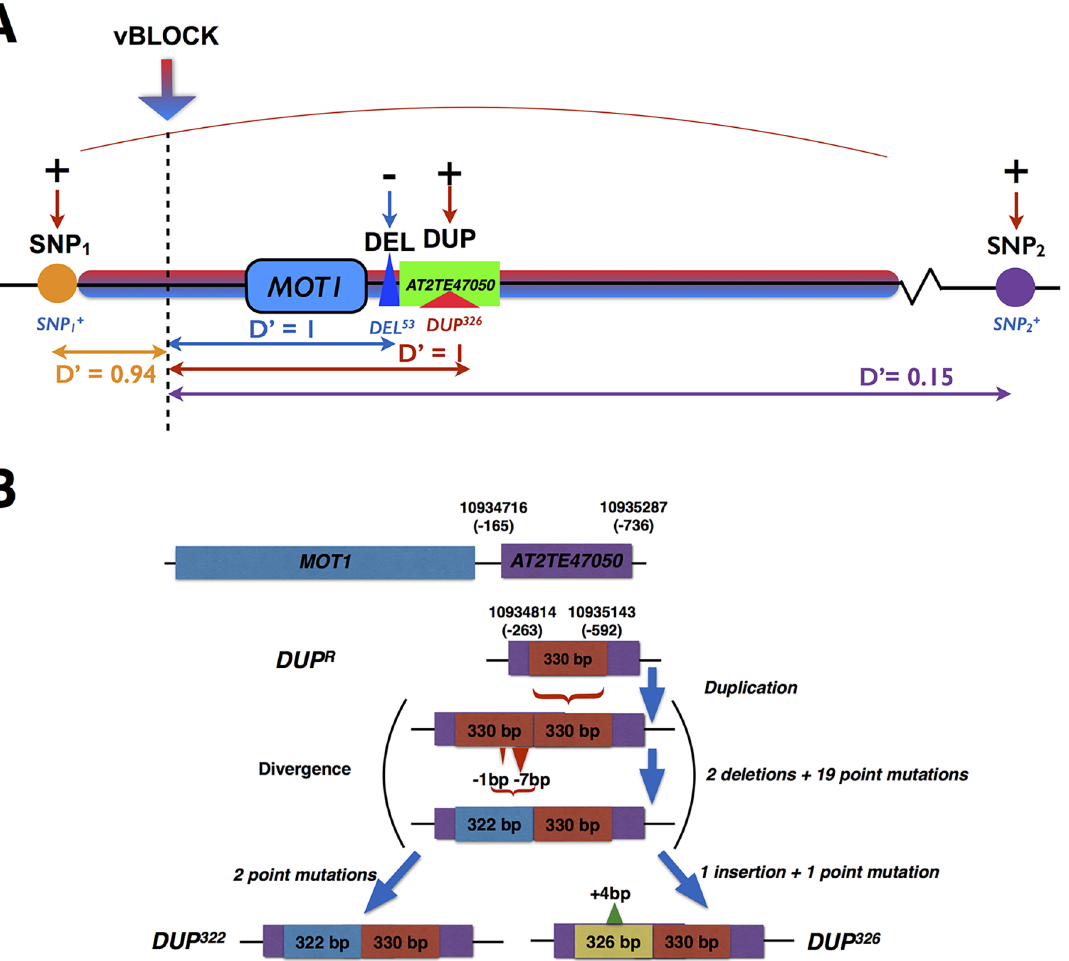
Fig 2. Schematic illustration of the complex locus on chromosome 2 associated with leaf molybdenum concentrations. (A) Multiple GWA and vGWA signals were detected to a complex locus around MOT1 . There was a strong LD (D ’ ) between three of the associated loci (SNP 1 , DEL and DUP) and the high-variance associated variant of vBLOCK ( vBLOCK hv ) that led to the extended vGWA signal (Red/blue arrow indicate leading vGWA SNP in the DGLM analysis). A fourth independent GWA association (SNP 2 ) was also detected upstream of vBLOCK. The direction of the effects for the minor alleles at the significantly associated loci ( SNP1 + , SNP2 + , DEL 53 and DUP 326 ) relative to that of the major, reference allele are illustrated with + (increased) and — (decreased), respectively. In (B) we illustrate the differences between the reference allele at DUP ( DUP R ) and the two variants of the 330 bp duplication ( DUP 326 and DUP 322 ) in the transposable element AT2TE47050 in the promoter region of MOT1